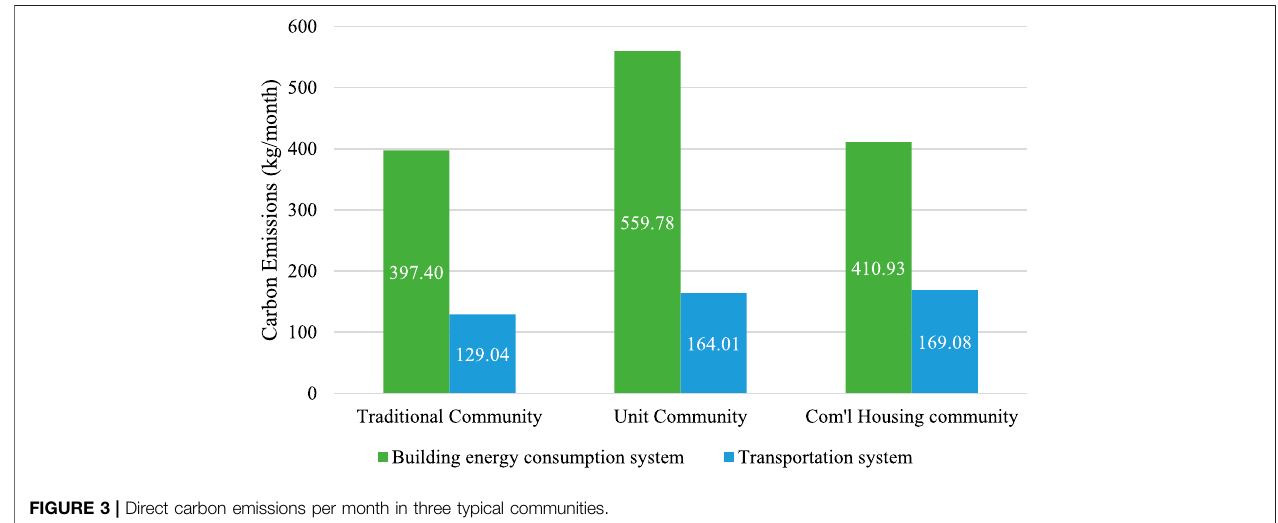
FIGURE 3 | Direct carbon emissions per month in three typical communities.